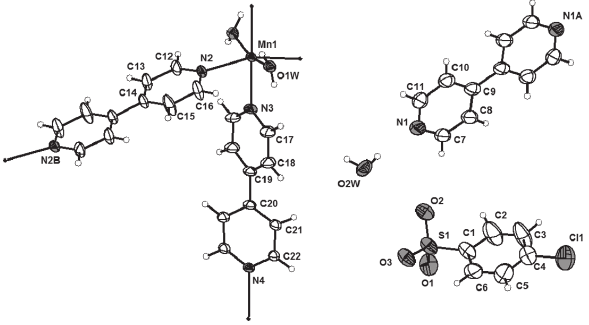
Table 1: Data collection and